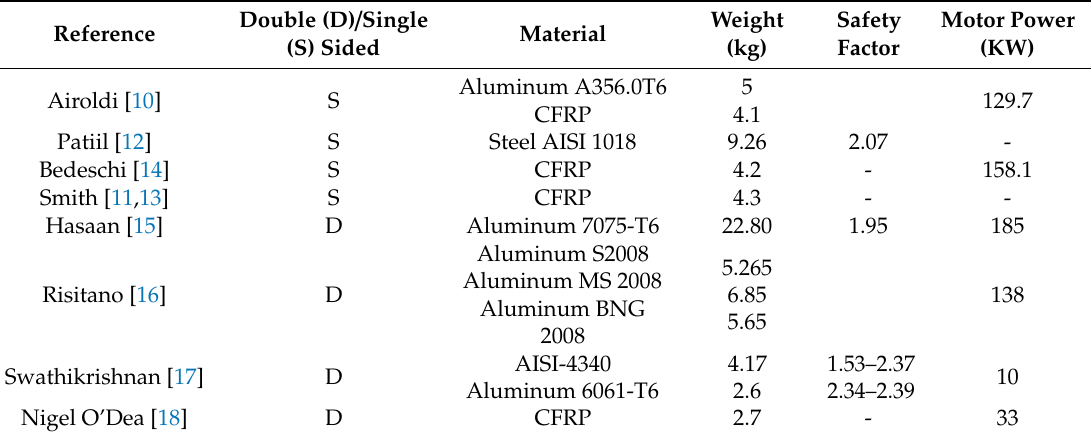
Table 1. Rear swingarm specifications in the